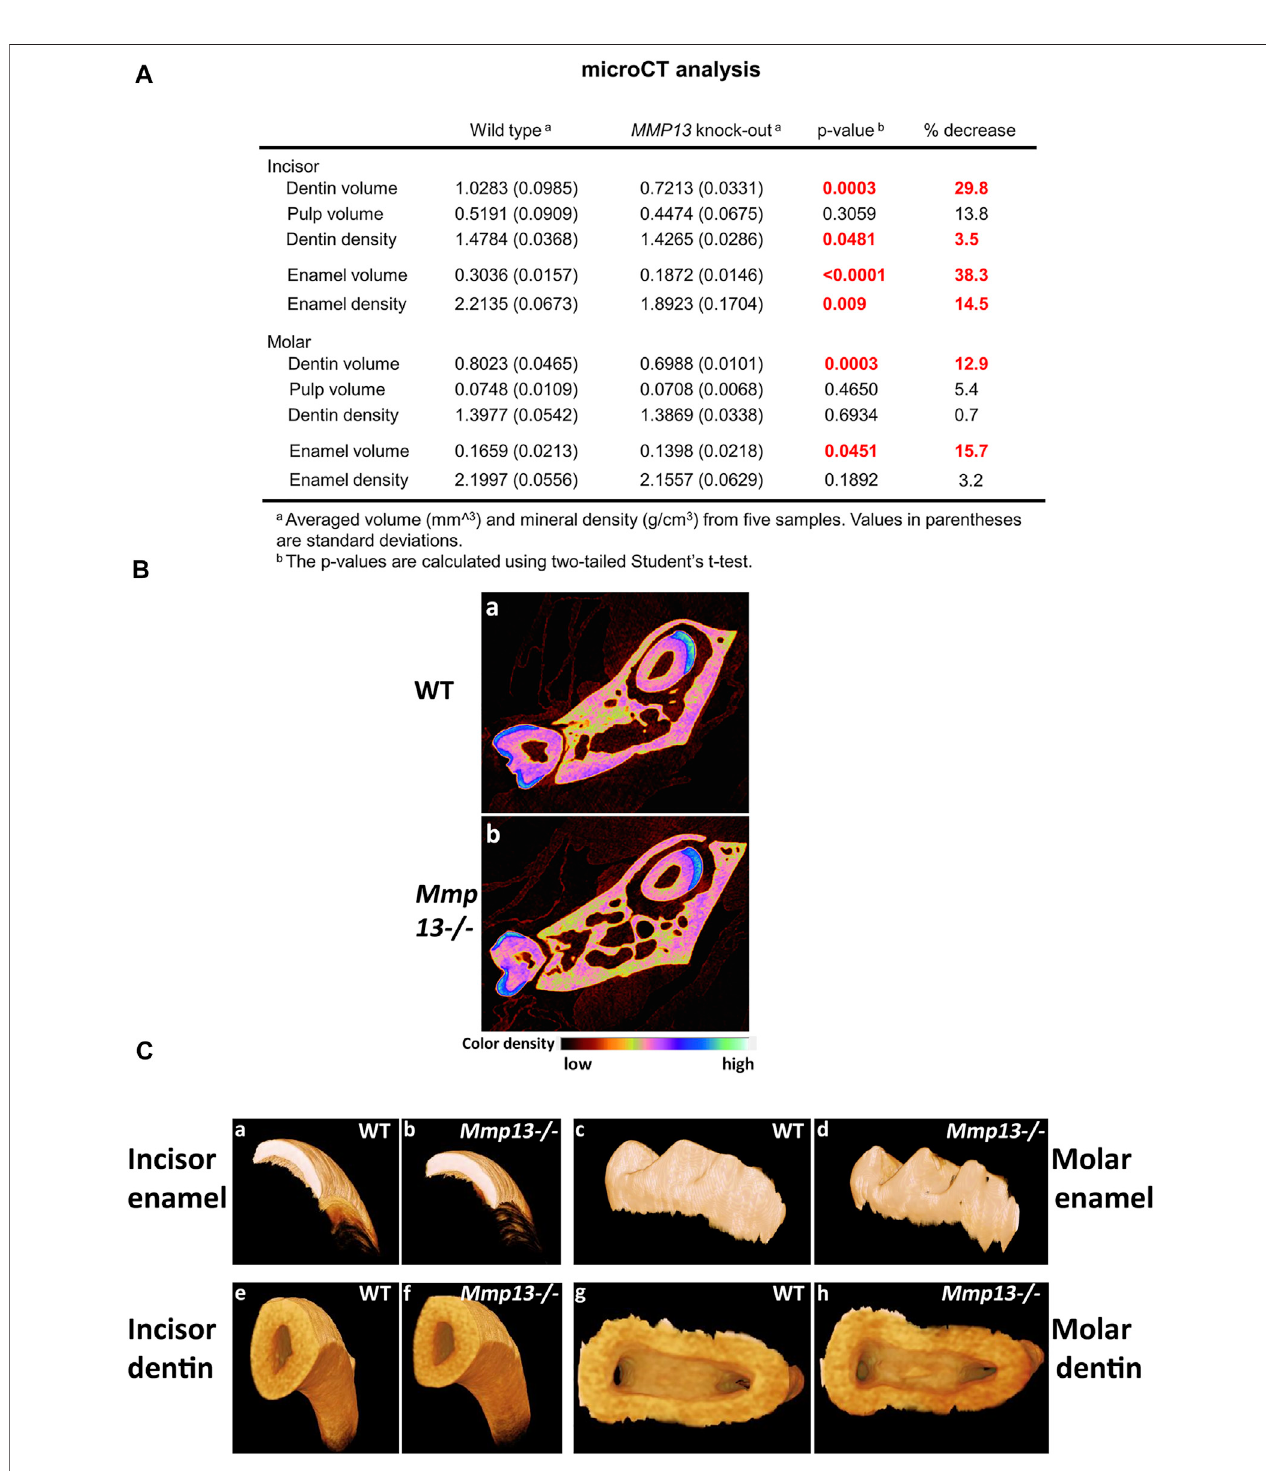
FIGURE 3 | MMP13 deletion reduces dentine enamel volume and density. (A) MicroCT analysis of the mandibular fi rst molar and incisor of 3-month-old WT comparedwith Mmp13 − / − miceshowsasigni fi cantdecreaseindentin,enamelvolume,andmineraldensityinincisorsaswellasdentinandenamelvolumeinmolars. (B) Densitometryformandibularincisorsandmolarsincrosssection (a,b) showssmallerteethwithreducedenamelvolume(highlightedblue). (C) µCTphotographscon fi rm smaller teeth (e, f) with phenotypically altered enamel but no evidence of wear at 3-month (c, d) . n = 5 for both groups and genotypes.